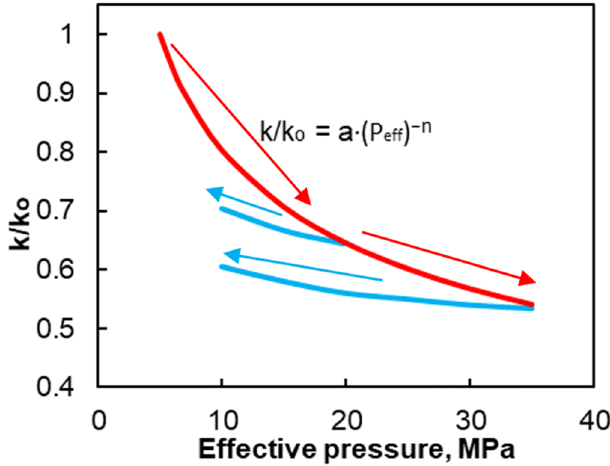
Figure 1. Influence of effective pressure on the relative permeability of rocks. The red arrows show the loading stage, the blue—unloading.